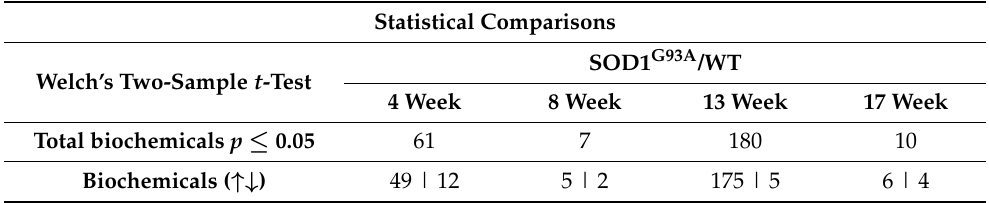
Table 1. ALS mice experienced metabolic alterations over the course of disease compared to WT. Statistical